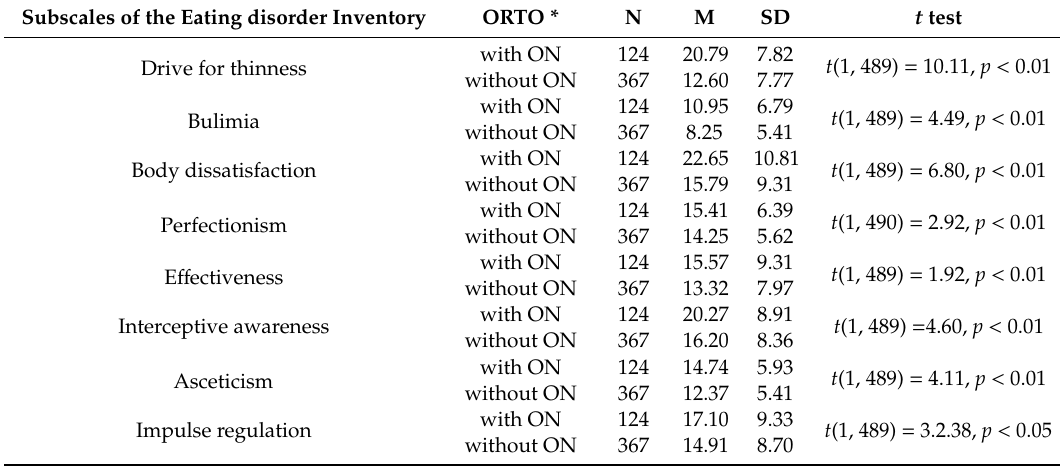
Table 3. Two sample t -test for di ff erences of means (ORTO) between subscales of EDI-2. Subscales of the Eating disorder